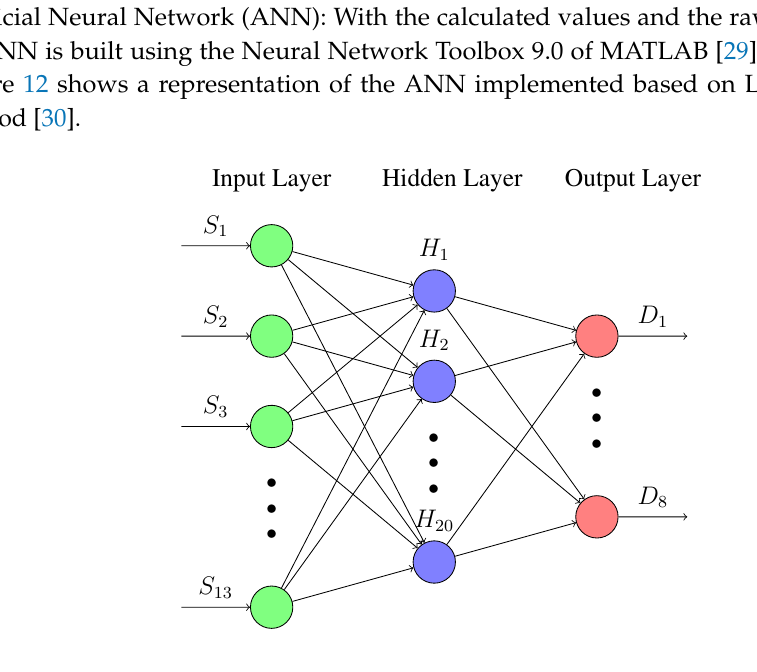
Figure 12. Artificial neural network